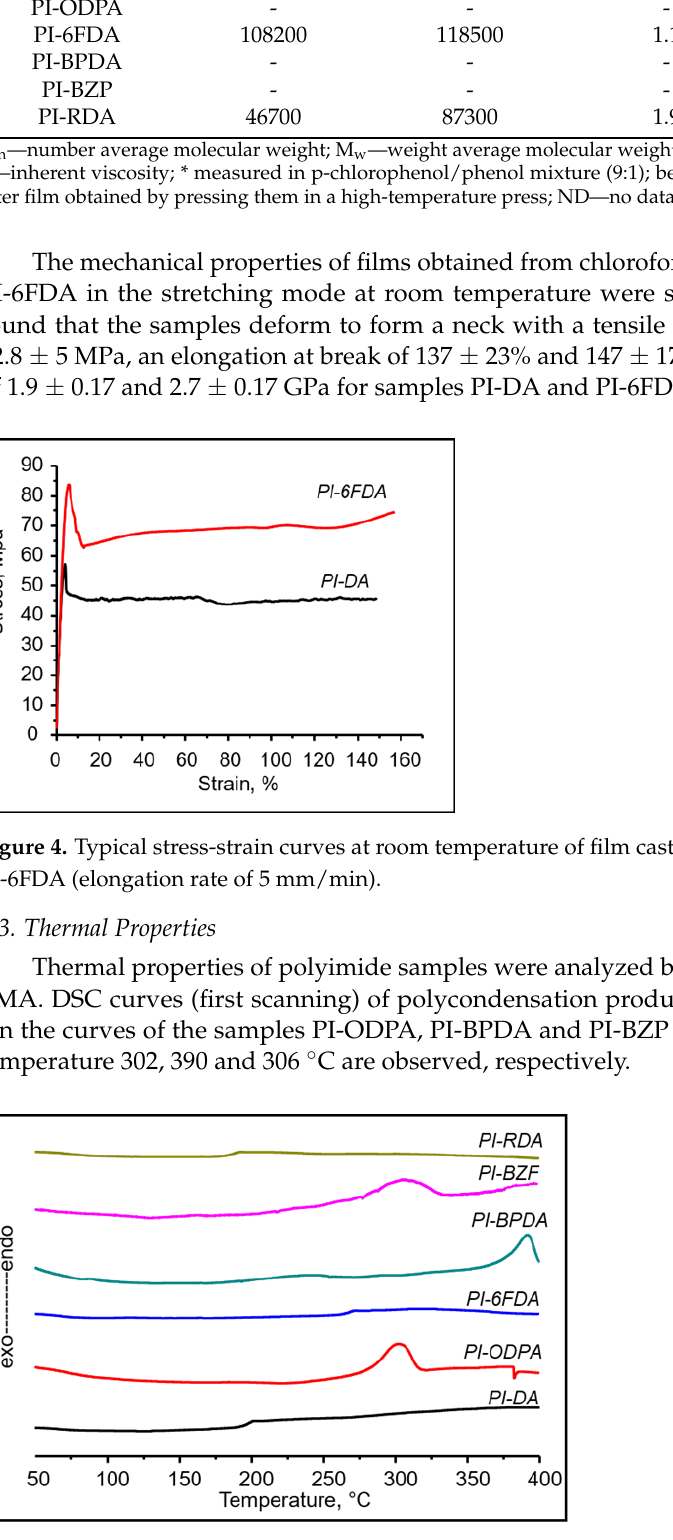
Figure 5. DSC curves of obtained PI. The first scanning. (in argon atmosphere, 10 °C/min).